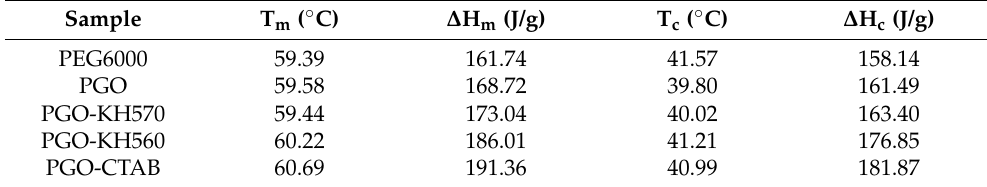
Table 1. Latent heat performance parameters of PEG6000 and GO-PEG